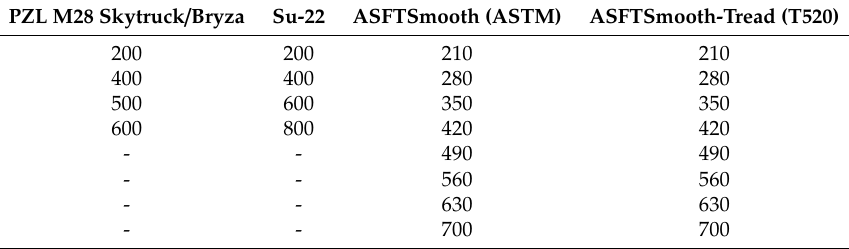
Table 1. Wheel pressure values during measurements for individual tire types (values given in kPa).